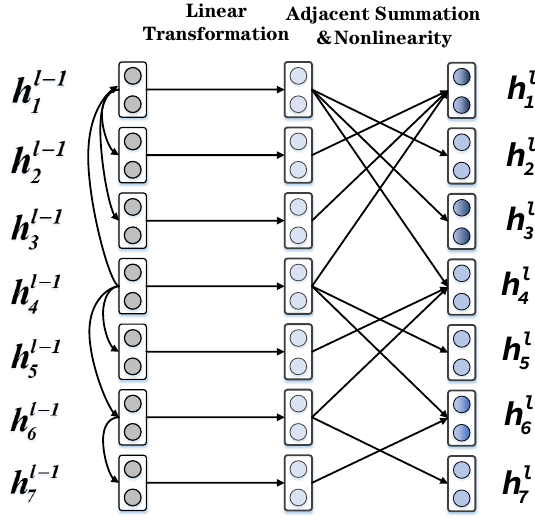
Figure 3. An example of a GCN